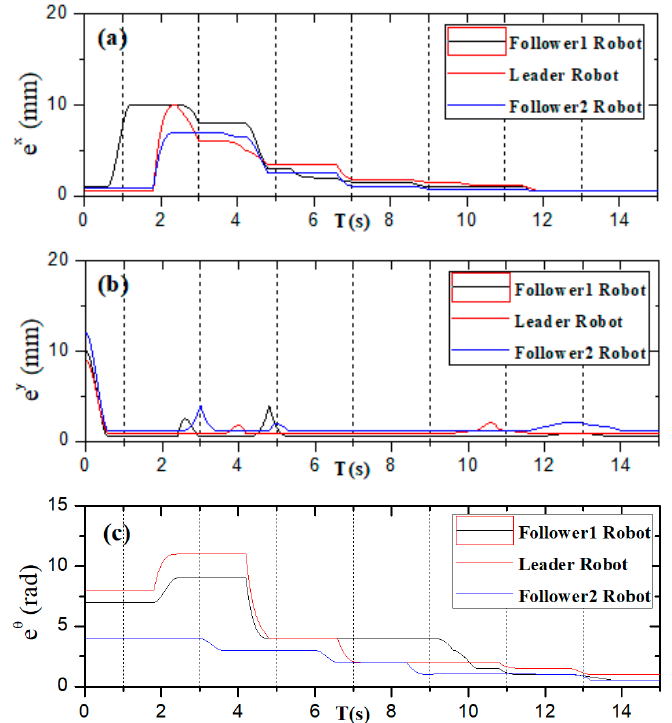
Figure 23. Error change of the x-axis, y-axis and rotation angle. ( a ) x-axis; ( b ) y-axis; ( c ) rotation angle.